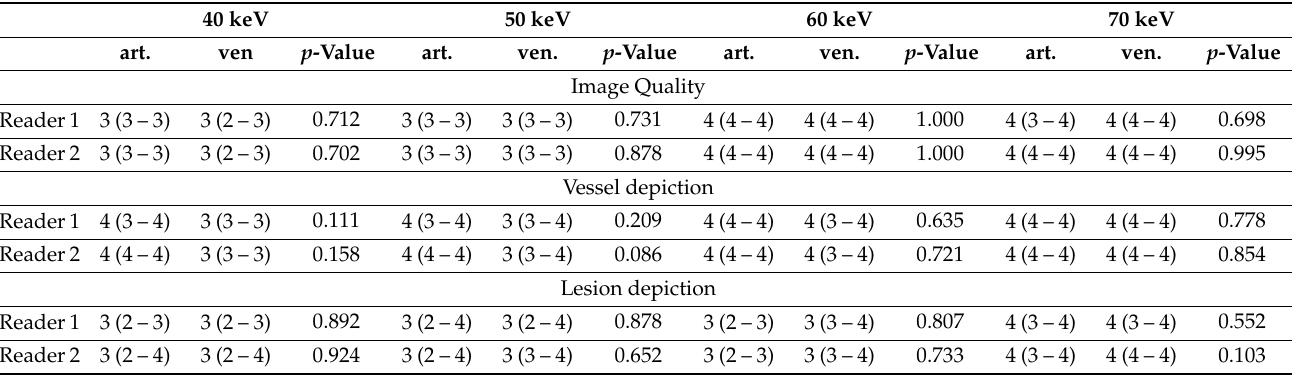
Table 15. Data are presented as median qualitative image analysis scores; data in parentheses are interquartile ranges.